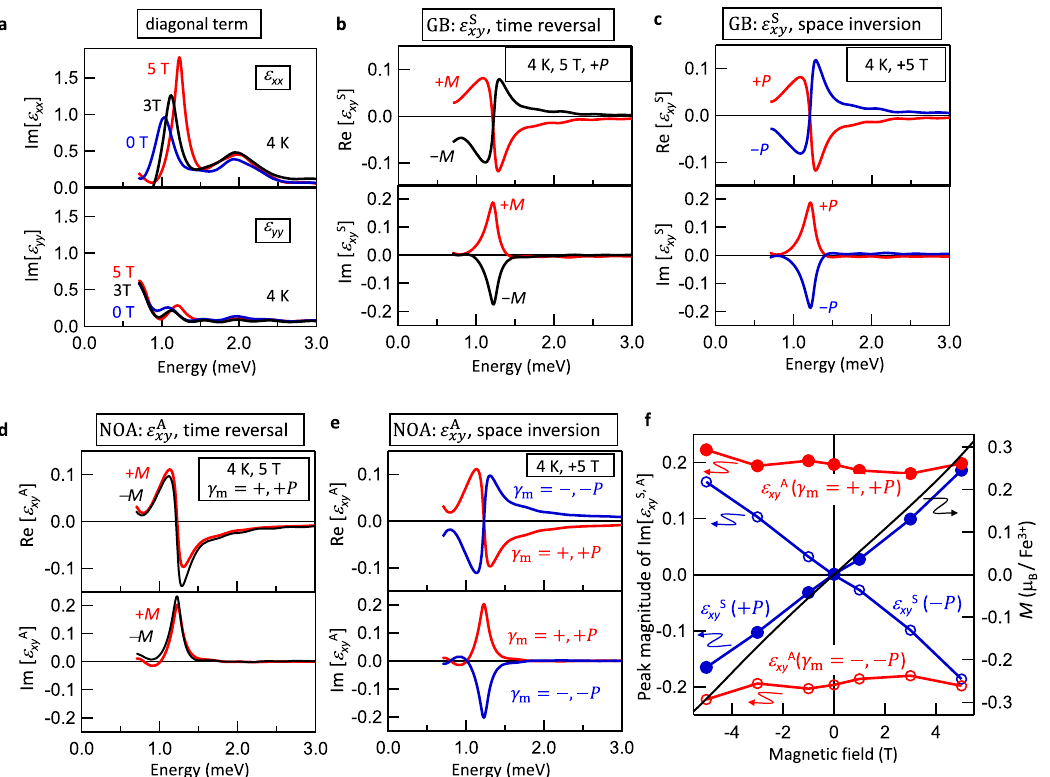
Fig. 2 Spectra of GB and NOA with response to P, M, and γ . a Magnetic fi eld dependence of the diagonal parts of effective dielectric tensor ( ε xx and ε yy ) m at 4 K in the magnetic fi eld ( H dc || [110]). Symmetric part of effective dielectric spectra ( ε S xy , see Eq. (1)) representing the optical rotation of GB under b time reversal and c space inversion. Antisymmetric part of effective dielectric spectra ( ε A xy ) representing the optical rotation of NOA under d time reversal and e space inversion. The magnetically-induced chirality γ m = ±, and equivalently the sign of P , are denoted. f Magnetic fi eld dependence of the peak magnitude of Im[ ε A xy ] (red) and Im[ ε S xy ] (blue) and the magnetization M (black line) of CuFe 1-x Ga x O 2 (x = 0.035) (right axis) 29 . The fi lled and open circles denote the peak magnitude for ( γ m = + , + P ) and ( γ m = − , − P ) states, respectively. (See Supplementary Note 2 for details of